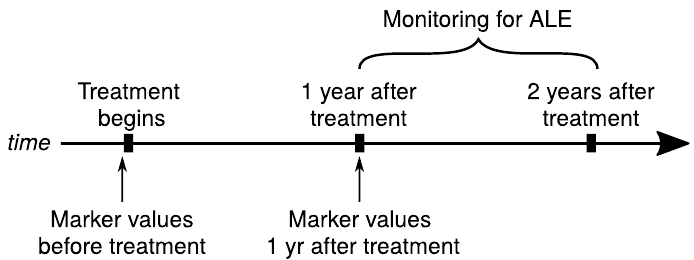
Figure 1. Timeline of the